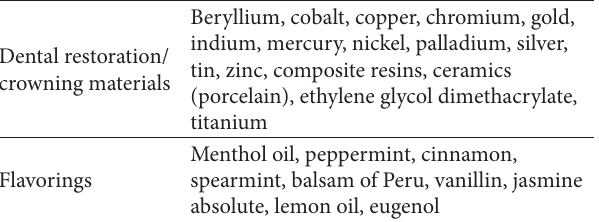
Table 4: Possible contact allergens to induce lichenoid contact